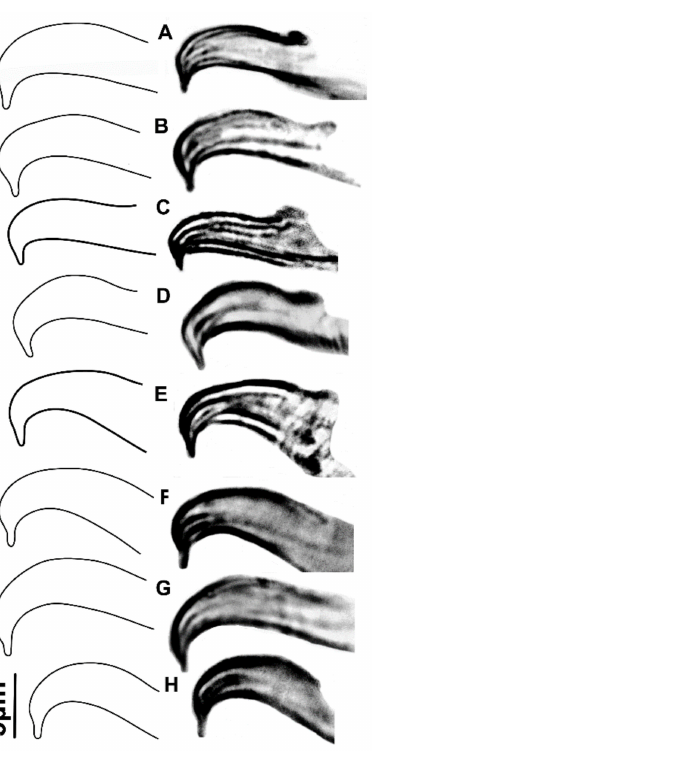
Figure 4. Illustrations/images of male aedeagi of different spider mite samples of the punicae complex; collected from Egypt {( D ), voucher no. 42, Mangifera indica }, Pakistan {( E ), voucher no. 71, M. indica —collected from the exact locality whence the original type of Oligonychus mangiferus was previously collected and described for the first time [9]; ( F ), voucher no. 73, Punica granatum }, and SA {( A ), voucher no. 1, M. indica ; ( B ), voucher no. 5 and ( H ), voucher no. 105, both Conocorpus erectus ; ( C ), voucher no. 21, P . granatum; and ( G ), voucher no. 80, Vitis vinifera